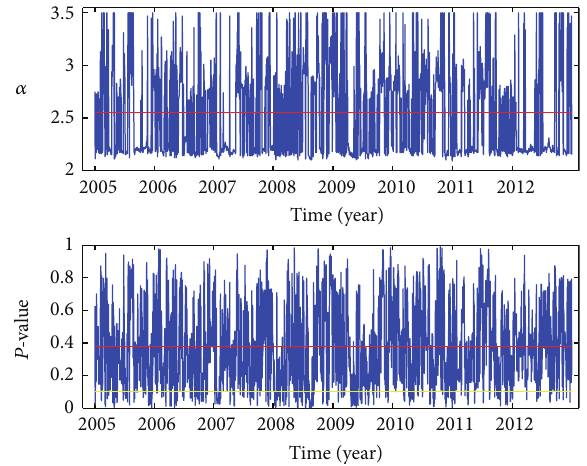
Figure 7: The estimated power-law exponent 𝛼 and the correspond- ing 𝑃 value of degree distribution of MST of 42 currencies in the international FX market as functions of time. In each panel, the red solid line stands for the corresponding statistical average value over the time investigated. In the bottom panel, the yellow solid line represents the value of 0.1. As proposed in [38], if the 𝑃 value is greater than 0.1, the power-law hypothesis is accepted for the investigated data; otherwise it is